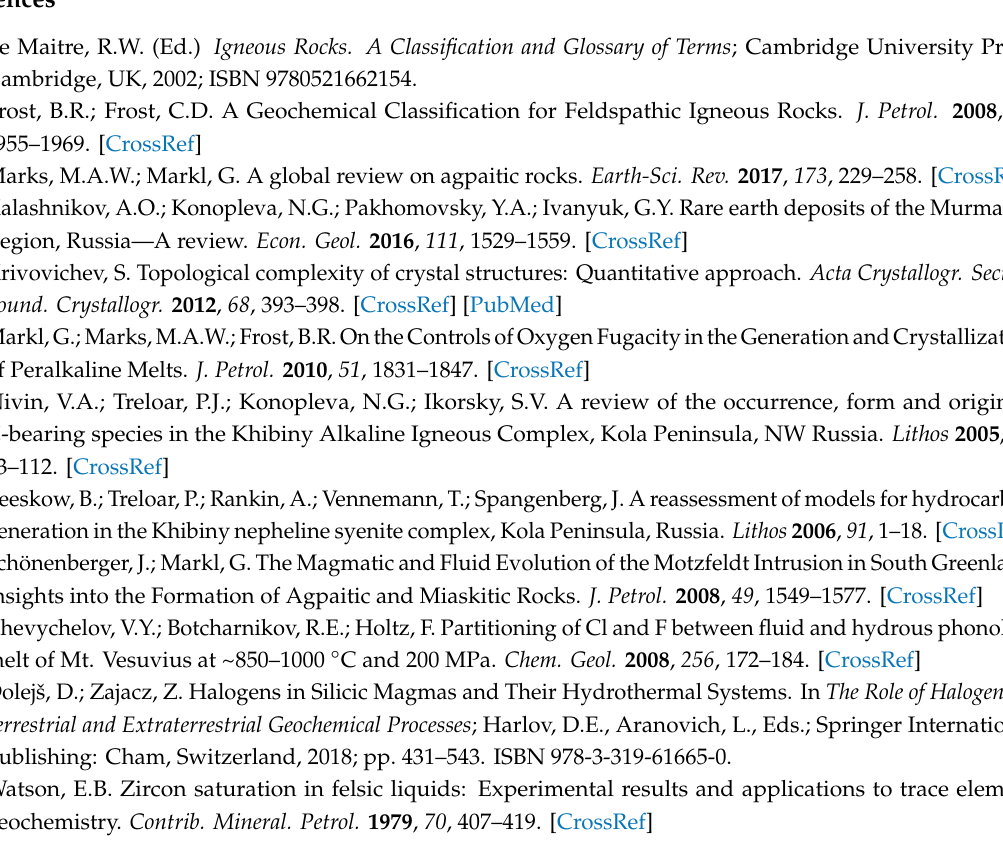
Table S1: parameters of chemical analyses; Table S2: modal composition of rock; Table S3: wet chemistry analyses of rock; Table S4: microprobe analyses of feldspar; Table S5: microprobe analyses of nepheline; Table S6: microprobe analyses of clinopyroxene; Table S7: microprobe analyses of amphibole; Table S8: microprobe analyses of eudialyte-group